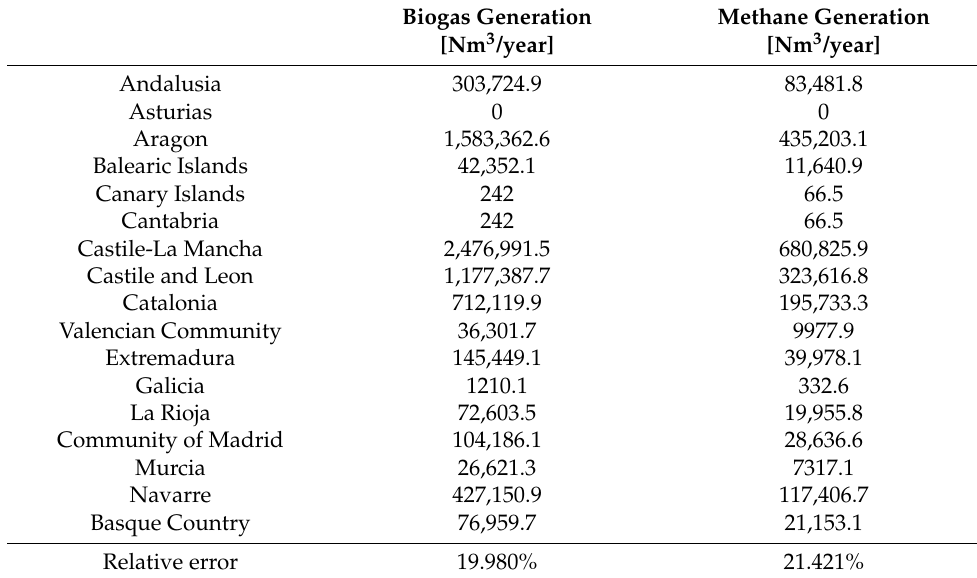
Table 7. Estimation of the biogas and methane generated with the anaerobic digestion of CrM.